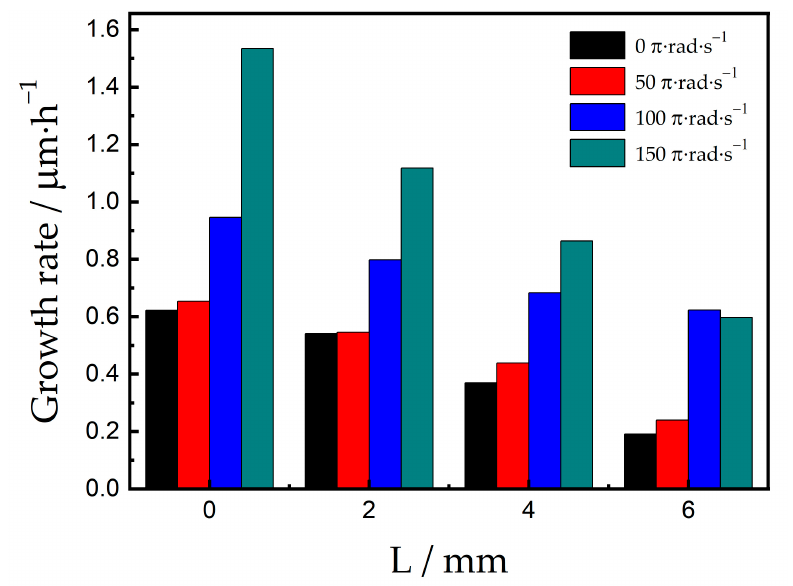
Figure 6. Growth rates of large-area diamond films along the L direction under a dynamic magnetic field with different angular frequencies.